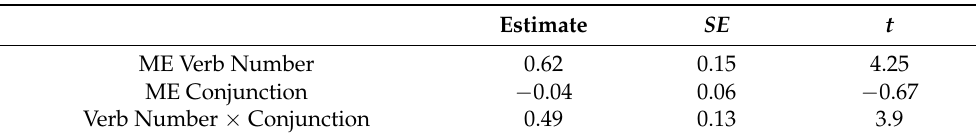
Table 3. Summary of the statistical results for the four baseline conditions, Experiment 1 (ME = main effect).